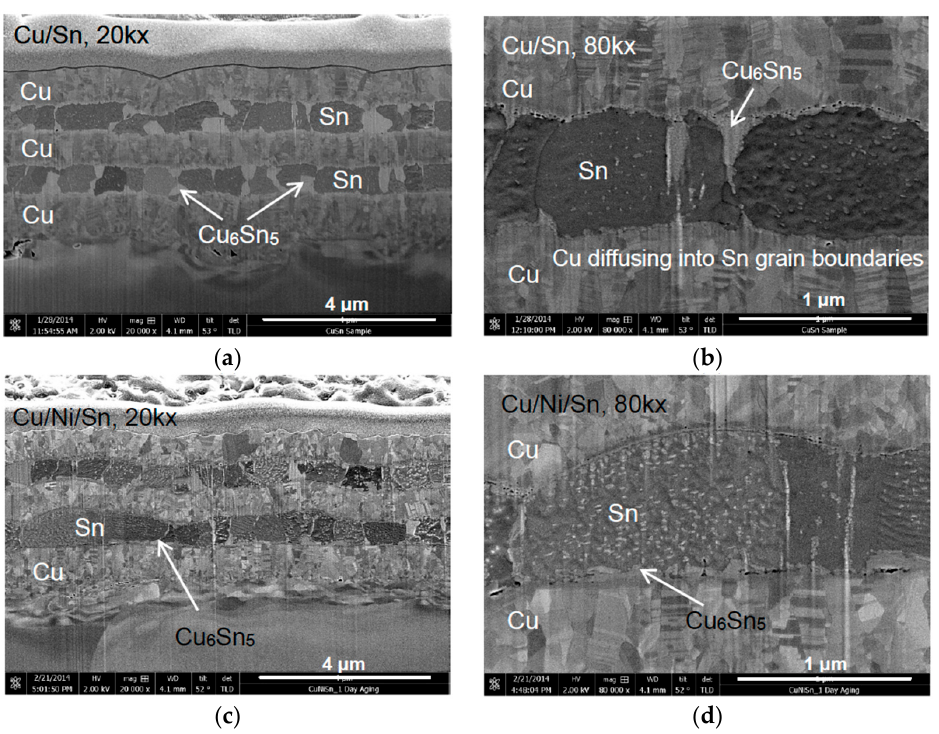
Figure 1. Field Emission Scanning Electron Microscope (FESEM) micrographs showing FIB milled cross sectional images of Cu/Sn ( a , b ) and Cu/Ni/Sn ( c , d ) aged at room temperature for one day at 20,000× and 80,000× magnifications, respectively.